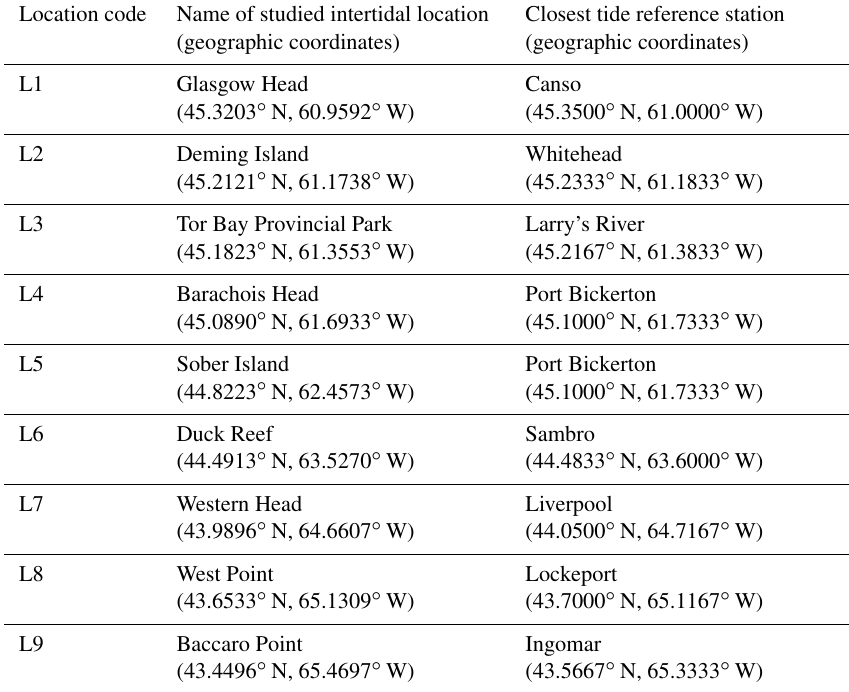
Table 1. Basic information about the nine wave-exposed intertidal locations surveyed for this study. Location